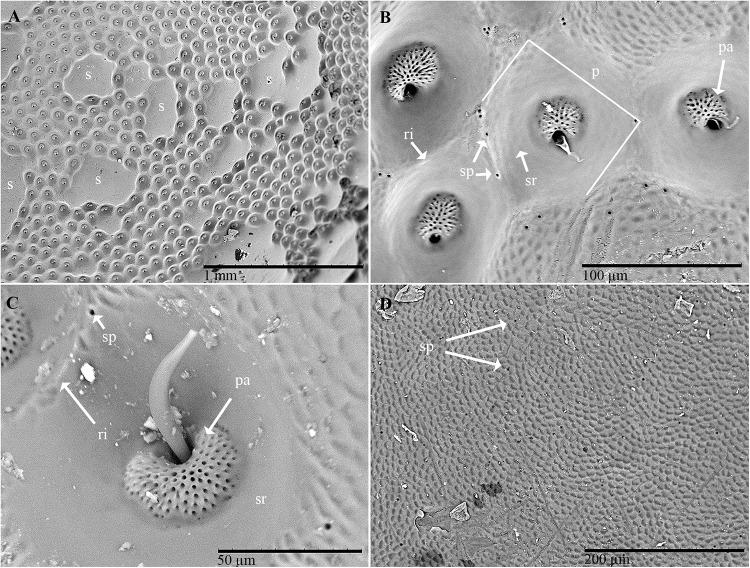
Scanning electron micrographs of C. tenebrionis: general view (A) and details of a few glandular openings (B) on rough fields of the male’s pronotum; (C) glandular openings on the male’s pronotum; (D) outer surface of the female’s pronotum. Specimens in panels (A,B,D) were washed according to Porcelli and Di Palma (2001); the specimen in panel (C) was washed according to Sands (1984). s, smooth fields; p, pore pit complex; pa, pore pit area; r, rim; sp, single pore; sr, smooth ring.